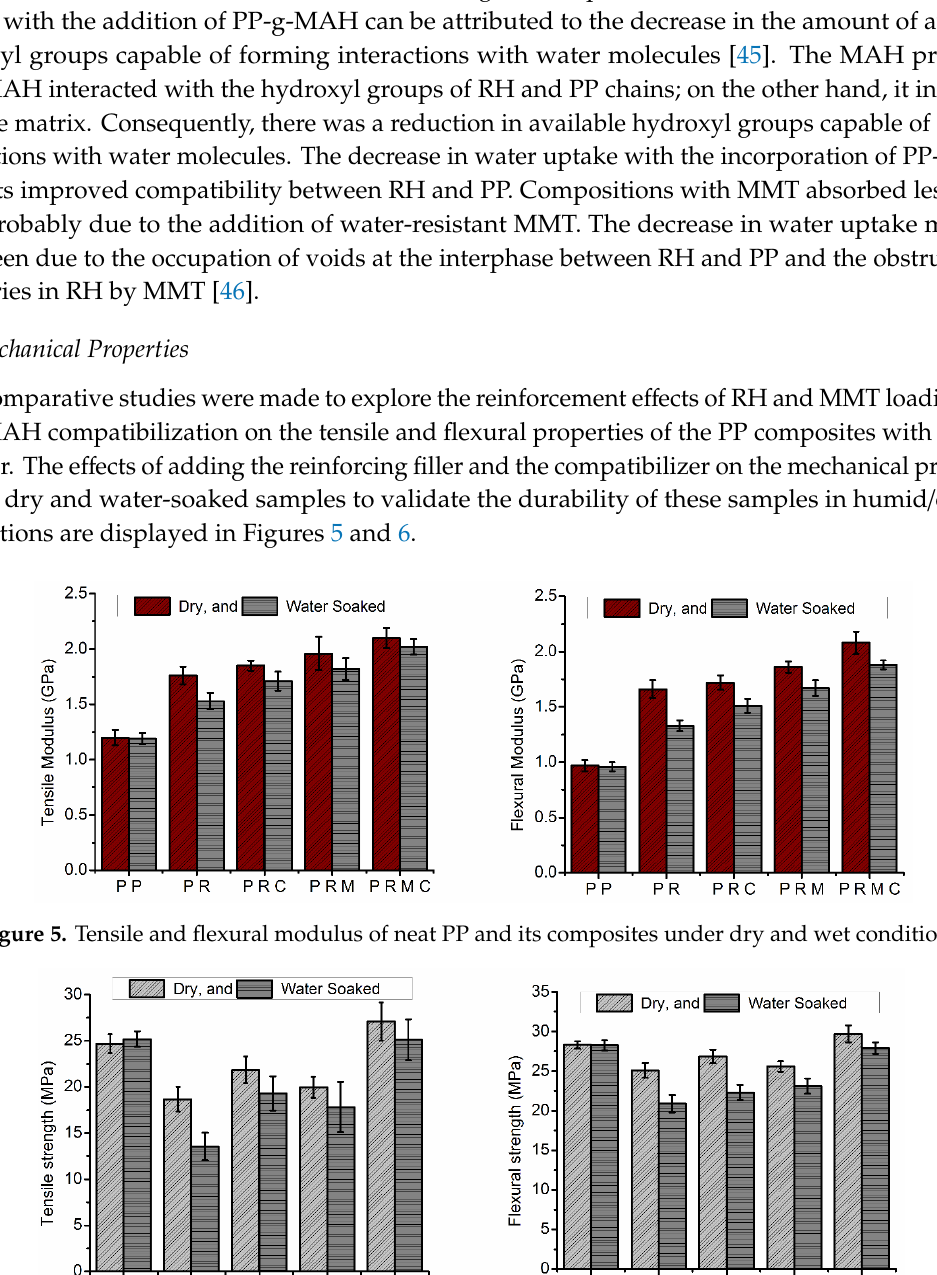
Figure 6. Tensile and flexural strength of neat PP and its composites under dry and wet